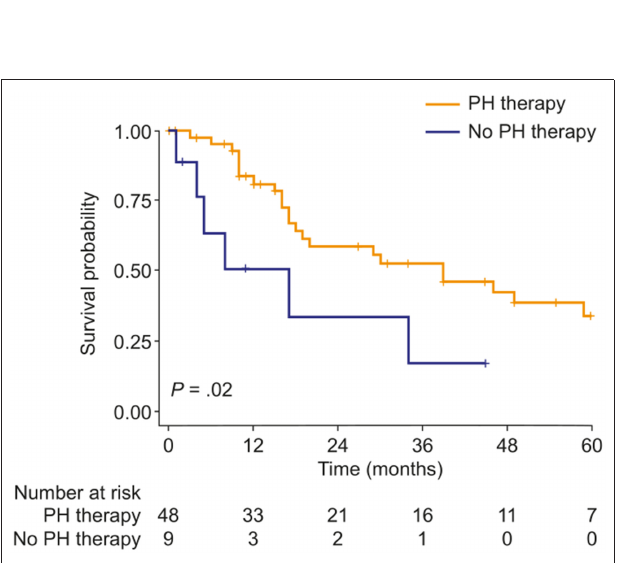
FIGURE 3 | Kaplan–Meier curves of survival probability in patients with PH due to COPD with both TAPSE/PASP and 6MWD values in the lowest or intermediate tertile, stratified by use of targeted PH therapy. 6MWD, 6-min walk distance; PH, pulmonary hypertension; TAPSE/PASP, tricuspid annular plane systolic excursion/pulmonary artery systolic